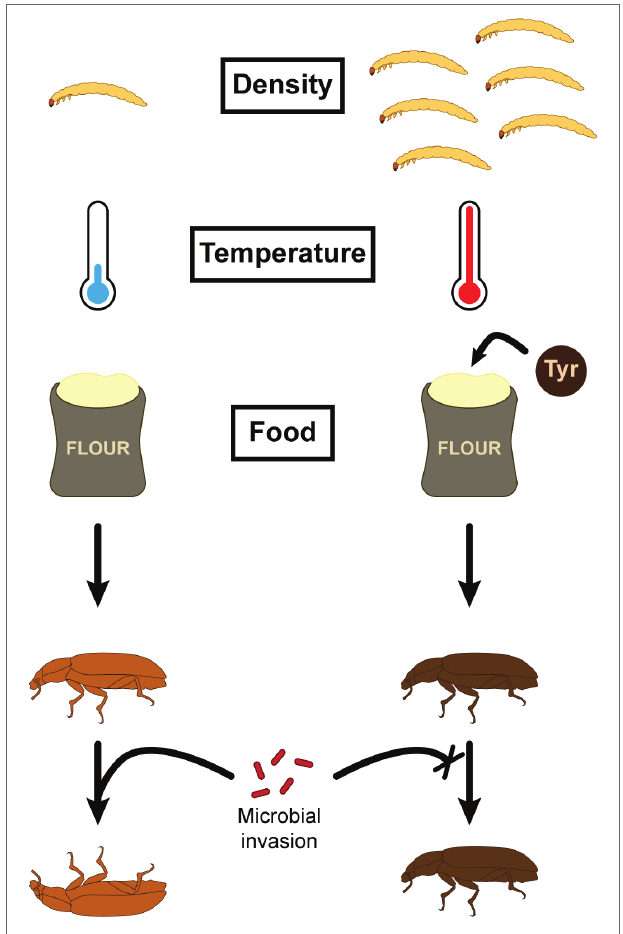
FIGURE 3 | Factors influencing T. molitor cuticle color and subsequent immune